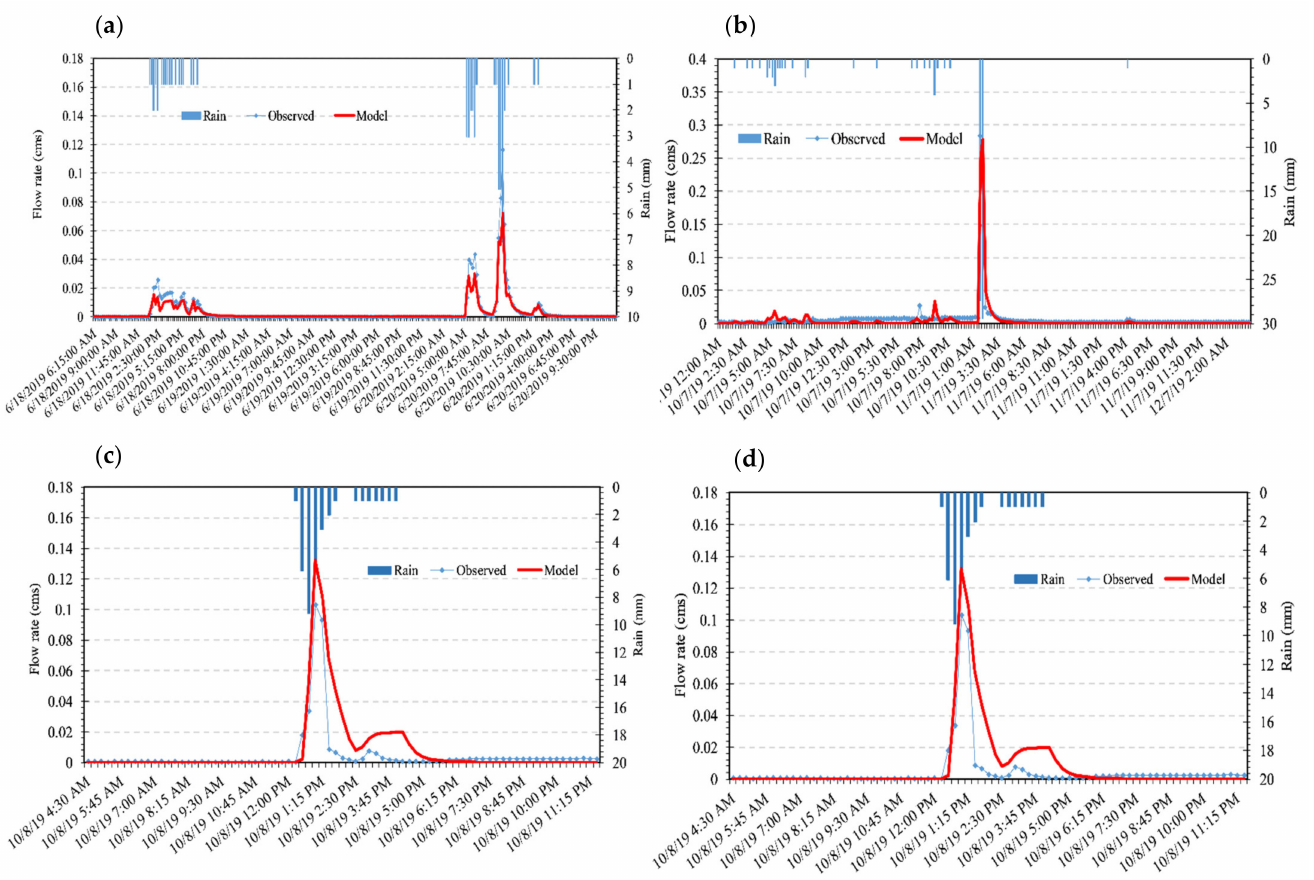
Figure 9. Calibration results for the storm events in ( a ) 18–20 June 2019, ( b ) 7 October–7 December 2019; validation results for the storm events in ( c ) 21 August 2019, ( d ) 8 October 2019. Table 5. Performance evaluation for the calibration and validation storms.